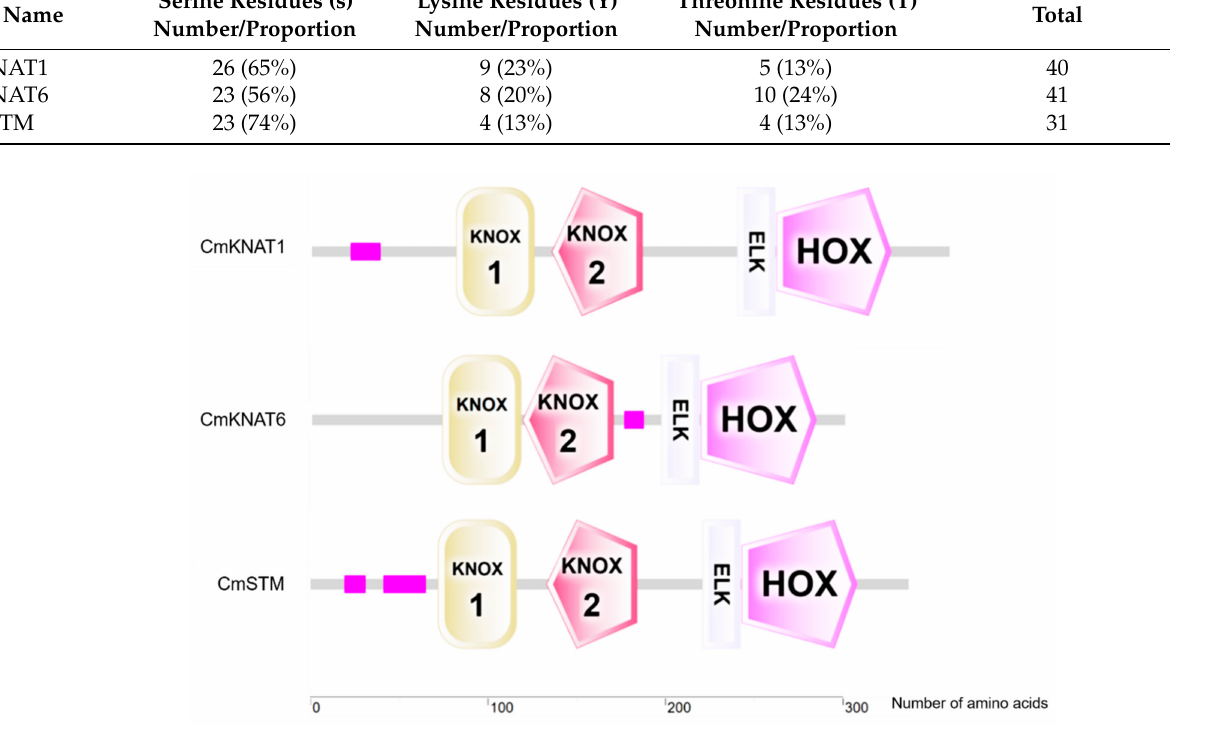
Figure 3. Distribution of conservative domains of KNOX proteins in